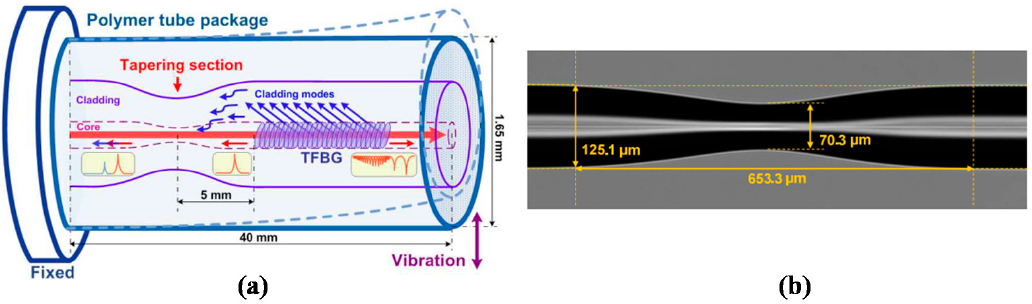
Figure 18. TFBG-based accelerometer [11]: ( a ) schematic and ( b ) photograph. Other researchers have increased the sensitivity of FBG accelerometers by improving their mechanical design. As shown in Figure 19a, Basumallick et al. increased the sensitivity of a cantilever FBG accelerometer by using a simple method, i.e., adding a polyimide patch to the cantilever beam that does not affect its resonant frequency [84,85]. This polyimide patch increased the distance between the central axis of the cantilever beam and FBG, improving the sensitivity of the accelerometer. The design is simple in structure, but it improves sensitivity without affecting bandwidth and other characteristics. Shi et